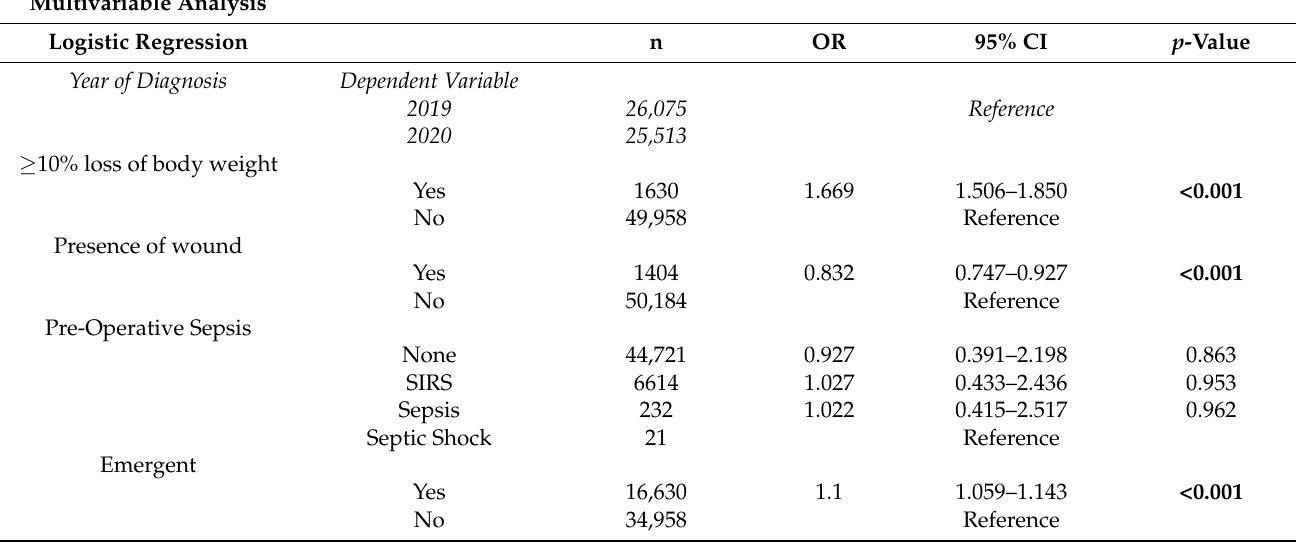
Table 3. Multivariable analysis and logistic